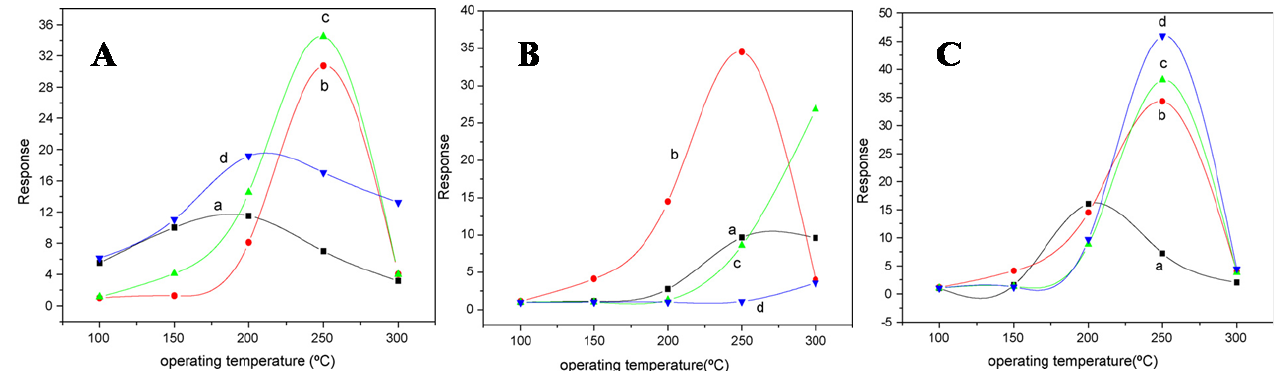
Figure 18. ( A ) Responses of (a) 0, (b) 20, (c) 40 and (d) 60 mol% ZnO nanocomposites calcined at 600 °C to 500 ppm NO 2 ; ( B ) responses of 40% ZnO–60% SnO 2 nanocomposite calcined at (a) 400 °C, (b) 600 °C, (c) 800 °C and (d) 1000 °C to 500 ppm NO 2 ; ( C ) responses of 40% ZnO–60% SnO 2 nano-